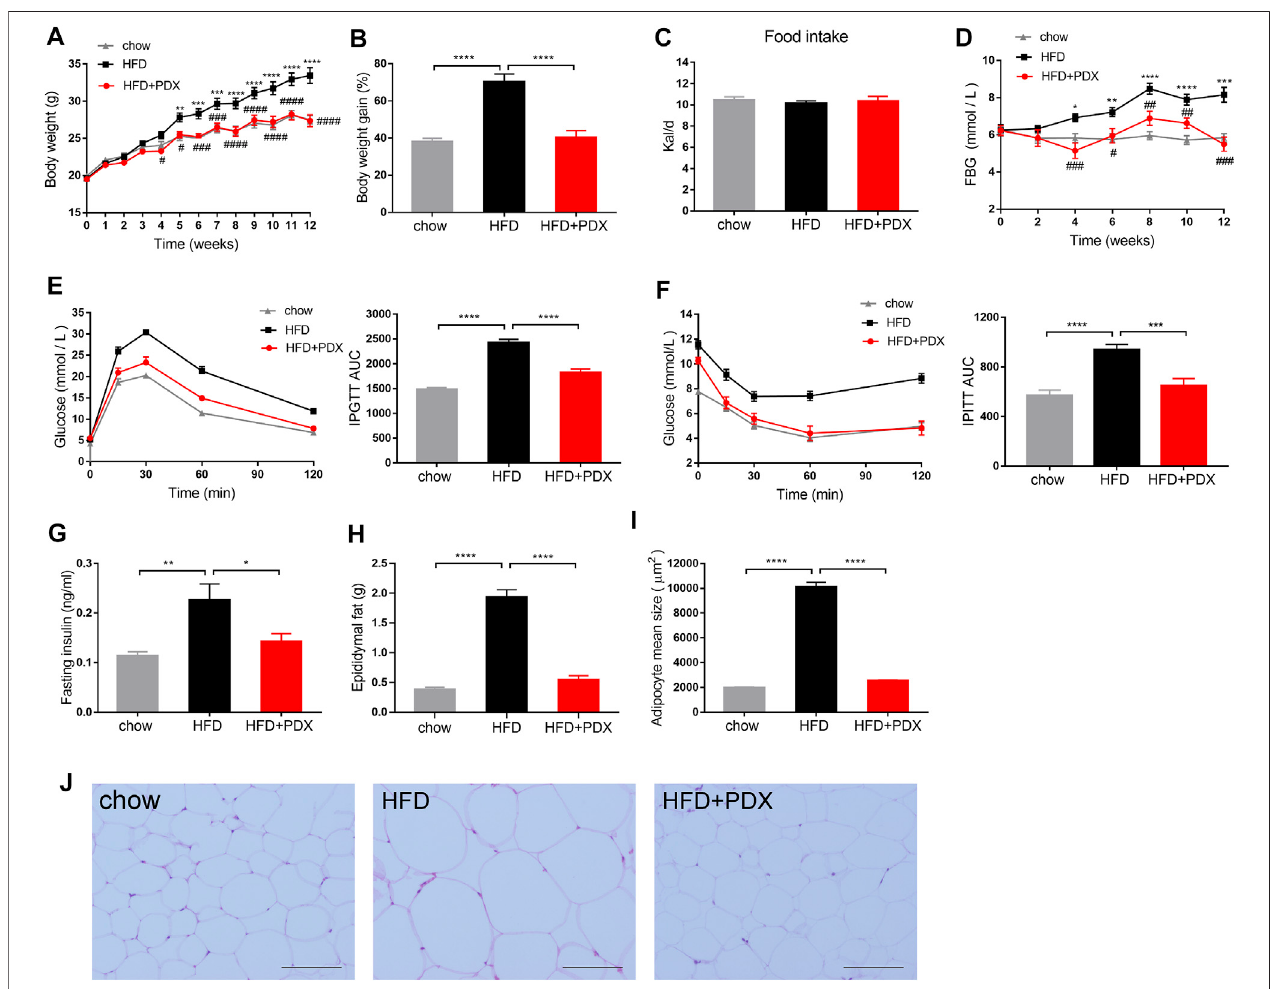
FIGURE 2 | PDX prevented obesity-related traits in HFD-fed mice (Part 1). (A) Body weight. (B) Body weight gain at week 12. (C) Food intake measured as kilocalories per day. (D) FBG. (E) IPGTT and AUCmeasuredduring the IPGTT (mM · min). (F) IPITT and AUC measured during theIPITT (mM · min). (G) Fasting insulin. (H) Epididymal fat accumulation. (I) Adipocyte mean size. (J) Representative images of H&E-stained epididymal adipose tissues. Scale bar, 100 μ m; magni fi cation, x200. AUC, area under the curve. n (cid:2) 12 per group. * p < 0.05; ** p < 0.01; *** p < 0.001; **** p <